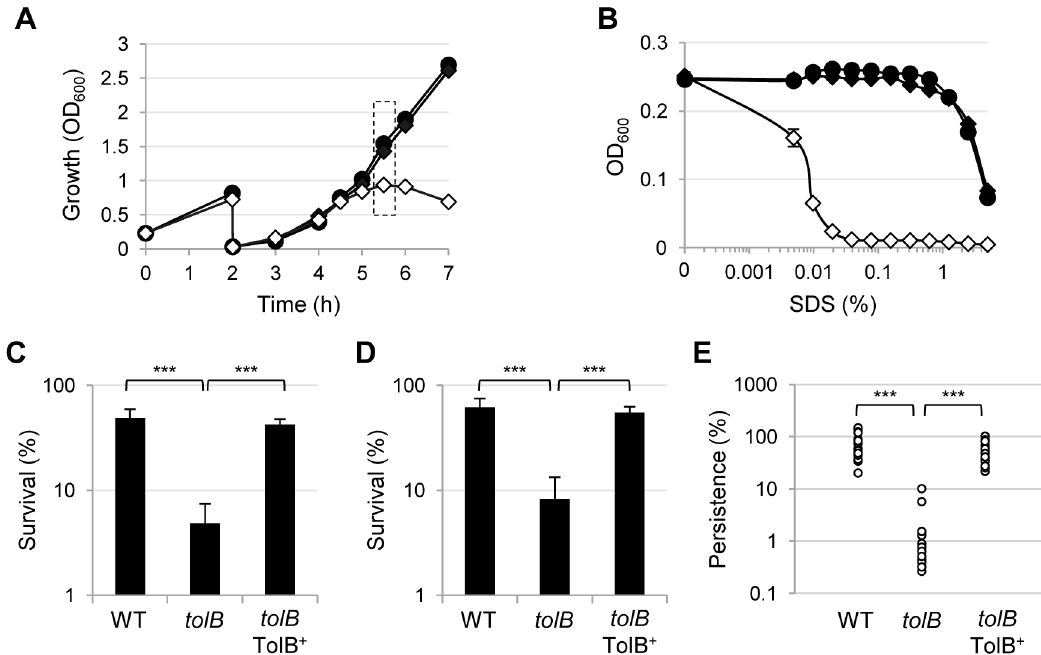
Figure 3. TolB is crucial for P.aeruginosa resistance and persistence. (A) Growth of PAO1 (circles) and PAO1 tolB conditional mutant (diamonds) at 37 u C in MH broth at 200 rpm in flasks after two successive subcultures in the presence (filled symbols) or in the absence (open symbols) of 0.2% arabinose. The graph is representative of several assays giving similar results. (B) Lytic effect of SDS (0–5%), measured as decrease in cell suspension turbidity (OD 600 ), on PAO1 wild-type cells (WT, filled circles), TolB-deficient mutant cells ( tolB , open diamonds) and TolB-proficient mutant cells ( tolB TolB + , filled diamonds). (C) Resistance of WT, tolB and tolB TolB + to the bactericidal activity of 50% human serum or (D) to the bactericidal antibiotic ofloxacin (0.5 mg/L), expressed as percent survival compared to untreated cells. Results in panels B–D are the mean ( 6 SD) of four independent experiments. (E) Persistence of WT, tolB and tolB TolB + cells in G. mellonella larvae at 2 h post-infection. Sixteen larvae per group were infected in three independent assays. ***, P , 0.001 (one-way